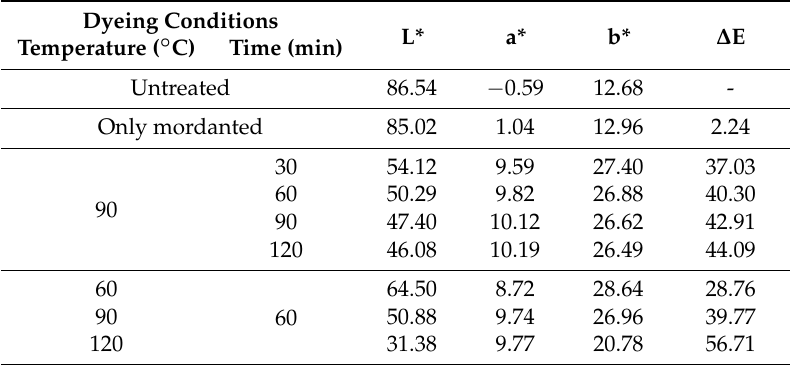
Figure 5. K/S values of wool fabrics dyed with spent coffee extract for 60 min as a function of dyeing temperature (all dying samples were mordanted with 1 wt % tannic acid aqueous solution): ( a ) untreated, ( b ) 60 ° C, ( c ) 90 ° C, and ( d ) 120 ° C. Table 1. Color values of wool fabrics dyed with spent coffee extract and mordanted with 1 wt % tannic acid aqueous solution.